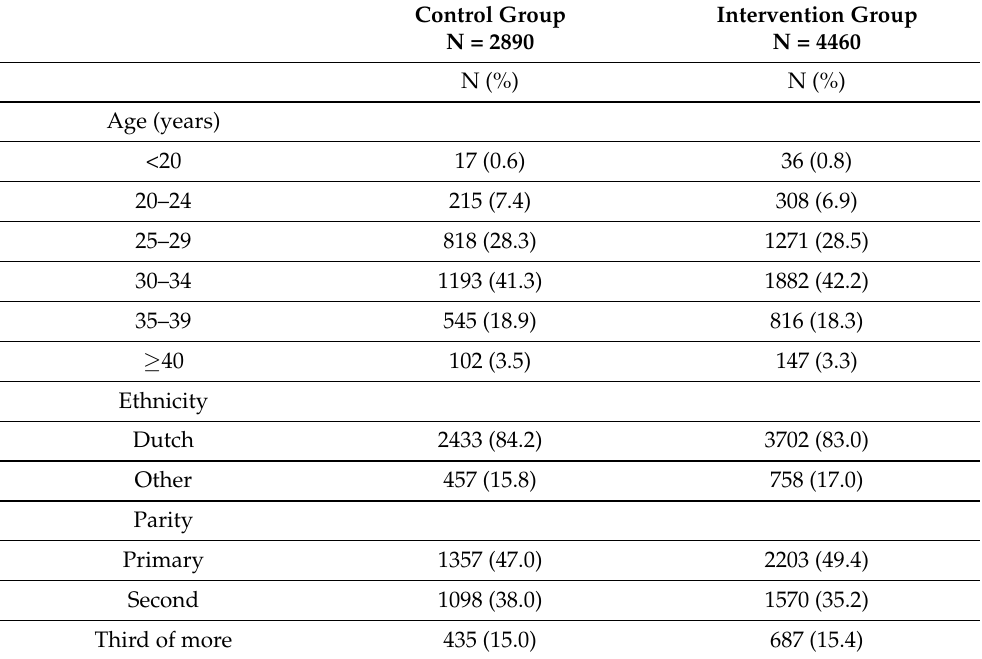
Table 1. Characteristics of the study participants (N =